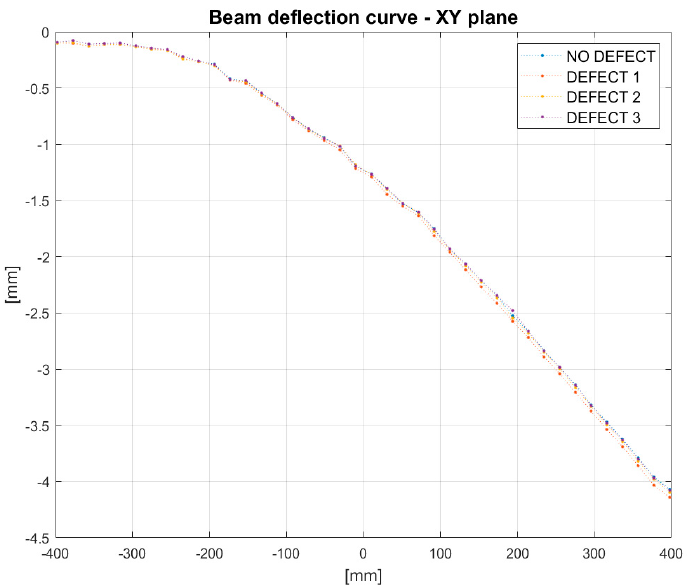
Figure 13. deflection curve-based deflection on synthetic images for different damage conditions introduced.